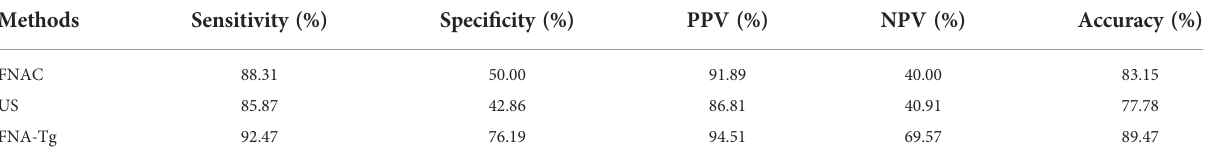
TABLE 5 Different methods to diagnose small CLNs.